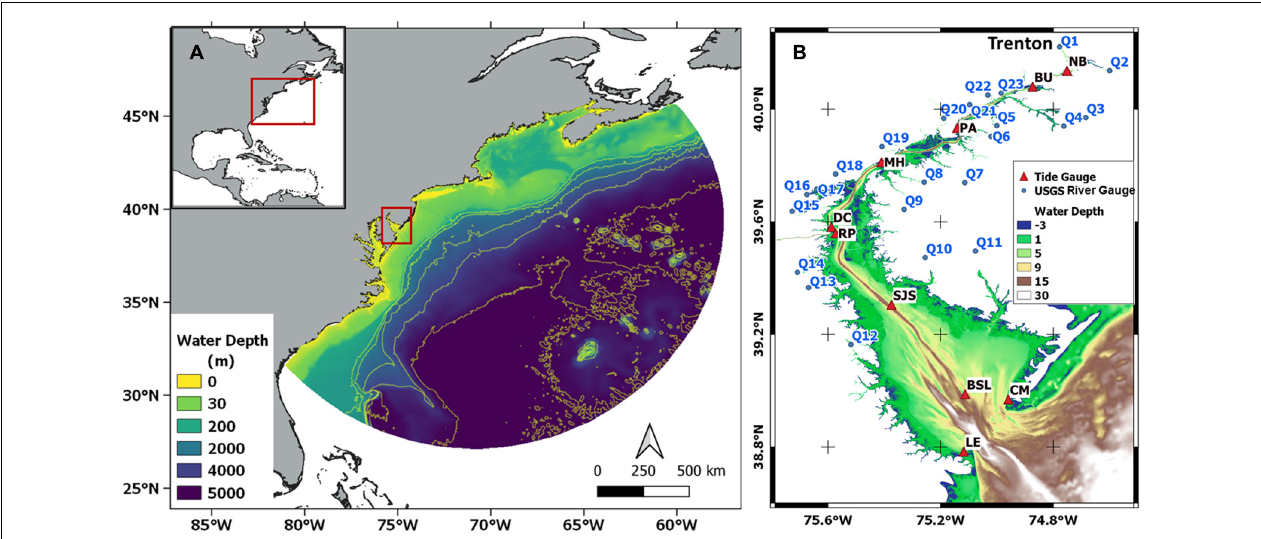
FIGURE 1 | (A) Model domain and bathymetry. (B) 10 NOAA tidal gauges and 23 U.S. Geological Survey river gauges with bathymetry inside the DBE. The 10 tide gauges in the DBE are listed as Lewes (LE), Cape May (CM), Brandywine Shoal Light (BSL), Ship John Shoal (SJS), Reedy Point (RP), Delaware City (DC), Marcus Hook (MH), Philadelphia (PA), Burlington (BU), and Newbold